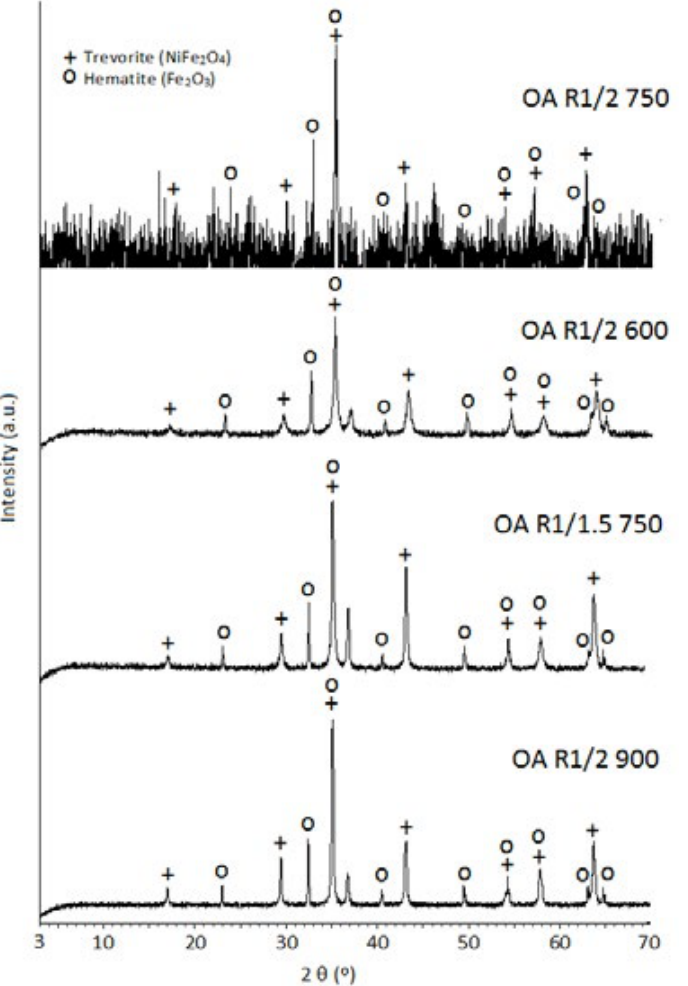
Fig. 3: XRD pattern of ferrites prepared by the hydro-chemical pathway